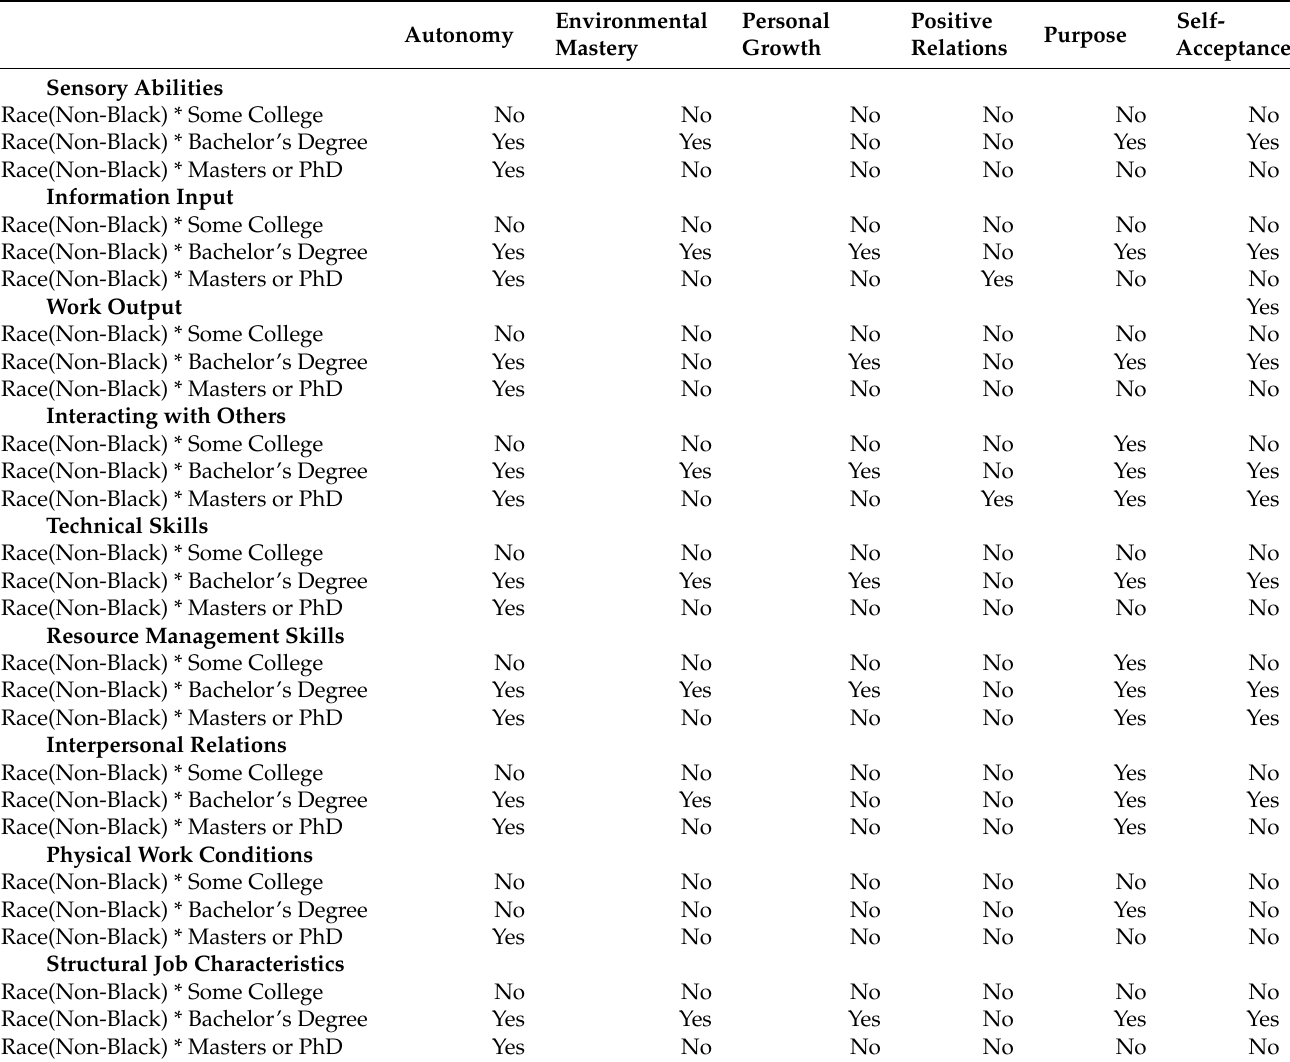
Table 4. Summary table indicating for which associations race (Non-Black) was a statistically signfi- cant moderator of education on Ryff’s Six Dimensions of Well-Being. Self- Environmental Personal Positive Purpose Autonomy Mastery Growth Relations